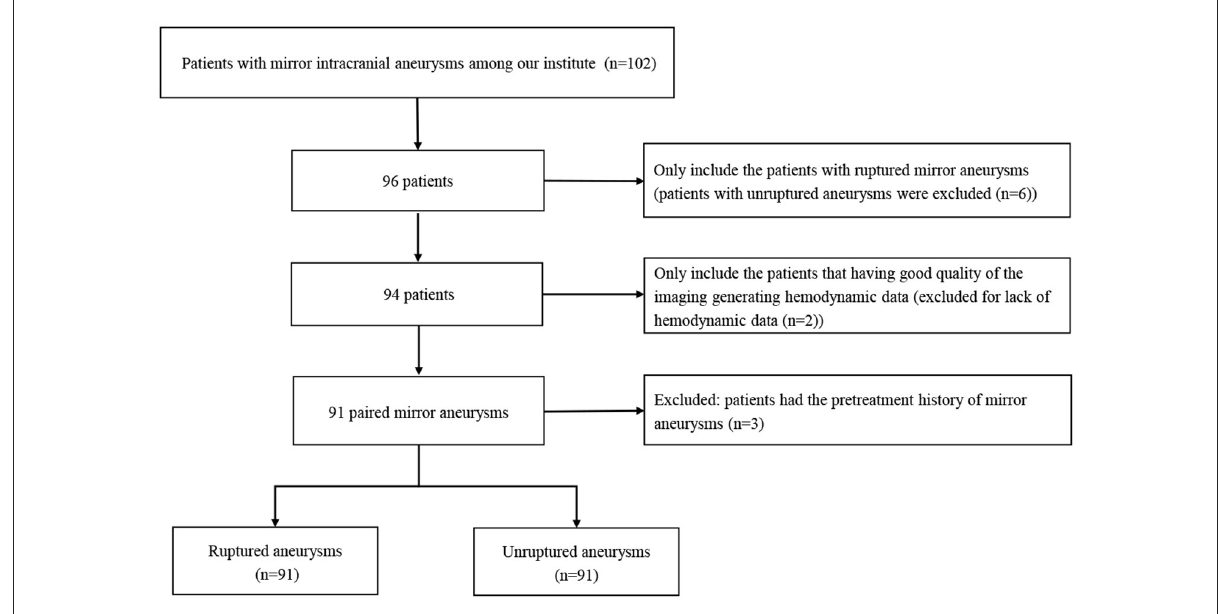
FIGURE1 The flow chart of patient selection.